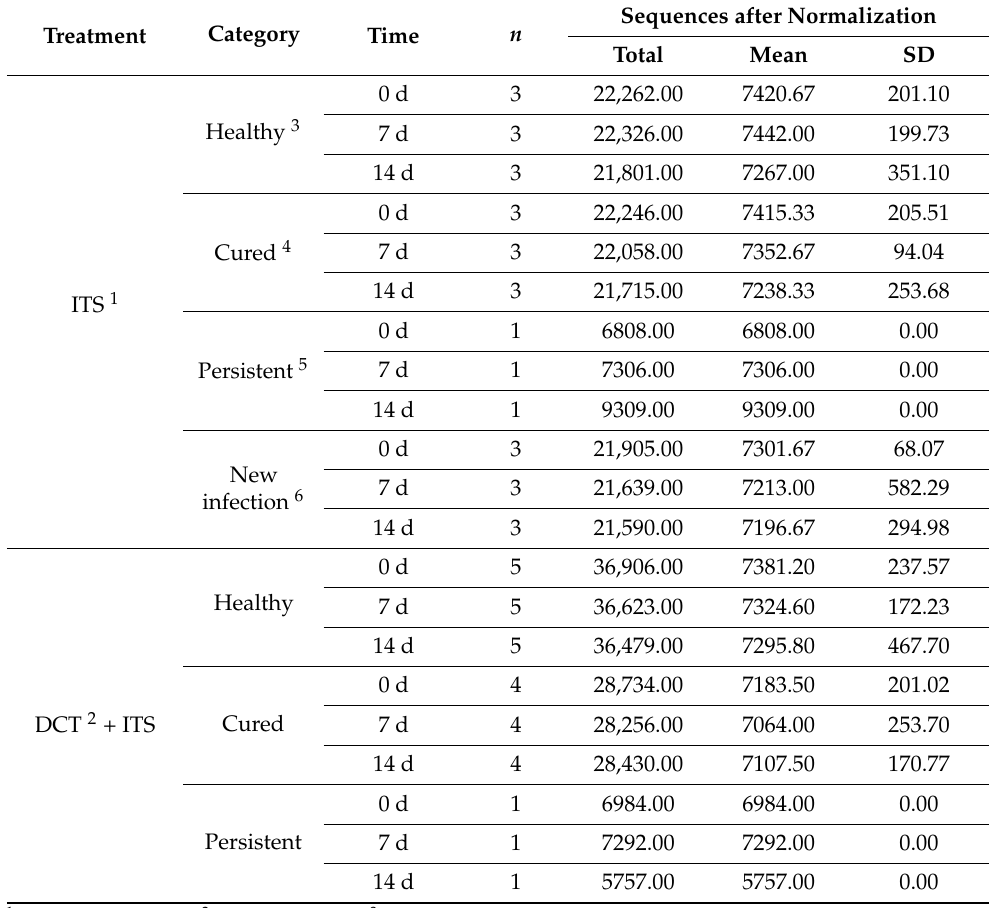
Table 2. Summary of sequencing of bacterial 16S rRNA of milk samples, grouped according to category, treatment, and time